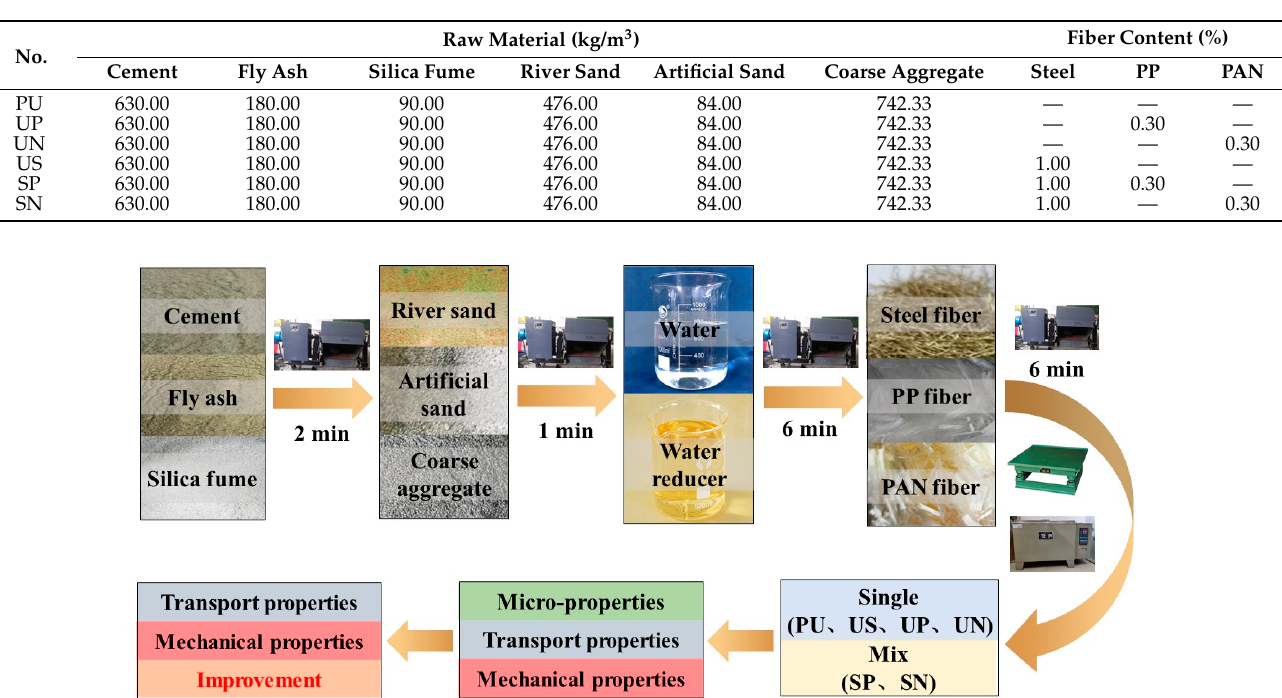
Figure 1. Mixing process of UHPC.